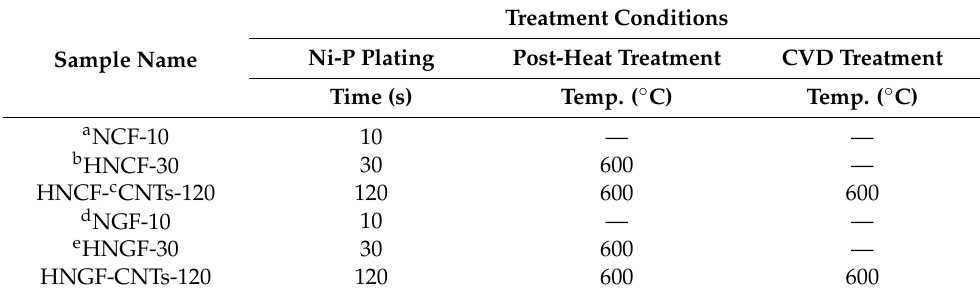
Table 1. Sample names according to treatment